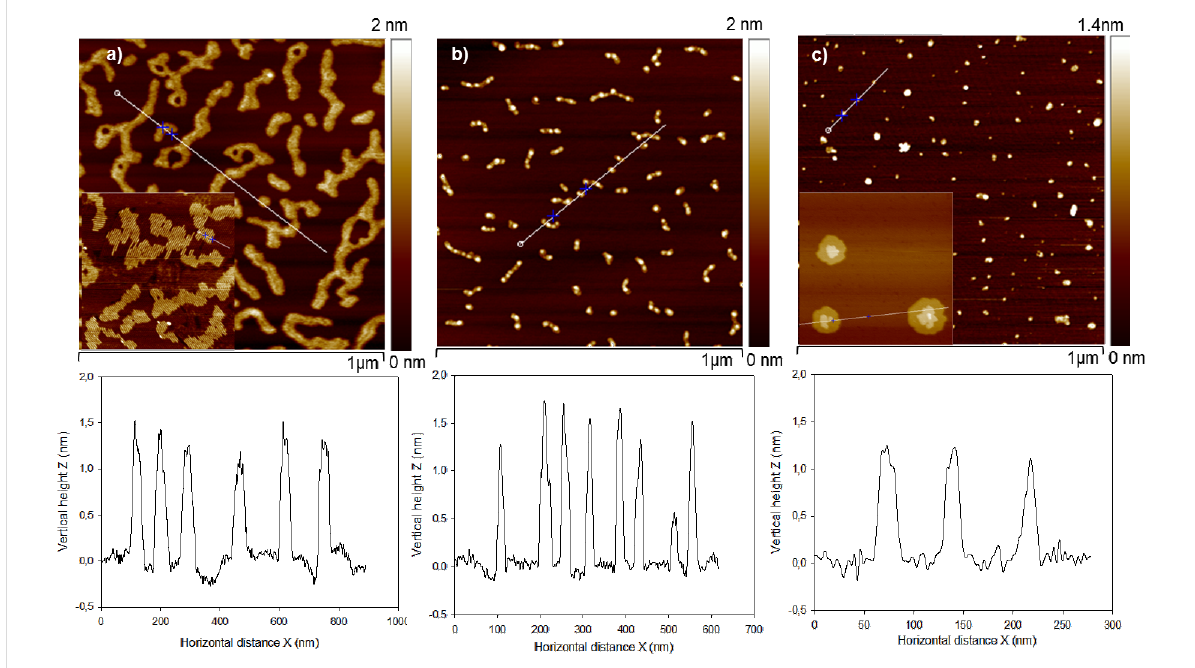
Figure 8: TM-AFM images of the UV–ozone-treated DODA–Keggin POM hybrid deposited on HOPG. a) Treatment time 1 min (inset shows the initial nanorod structure of the hybrid), b) treatment time 10 min, and c) UV–ozone-treated (10 min) DODA–Keggin POM hybrid deposited on mica (inset shows the initial nanosphere structure of the hybrid film on mica). Cross-section analyses taken along the white lines are shown below each image.